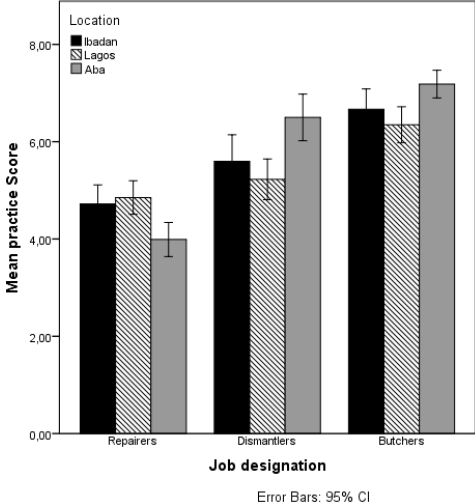
Figure 7. Mean Practice scores by Job designation and Location.